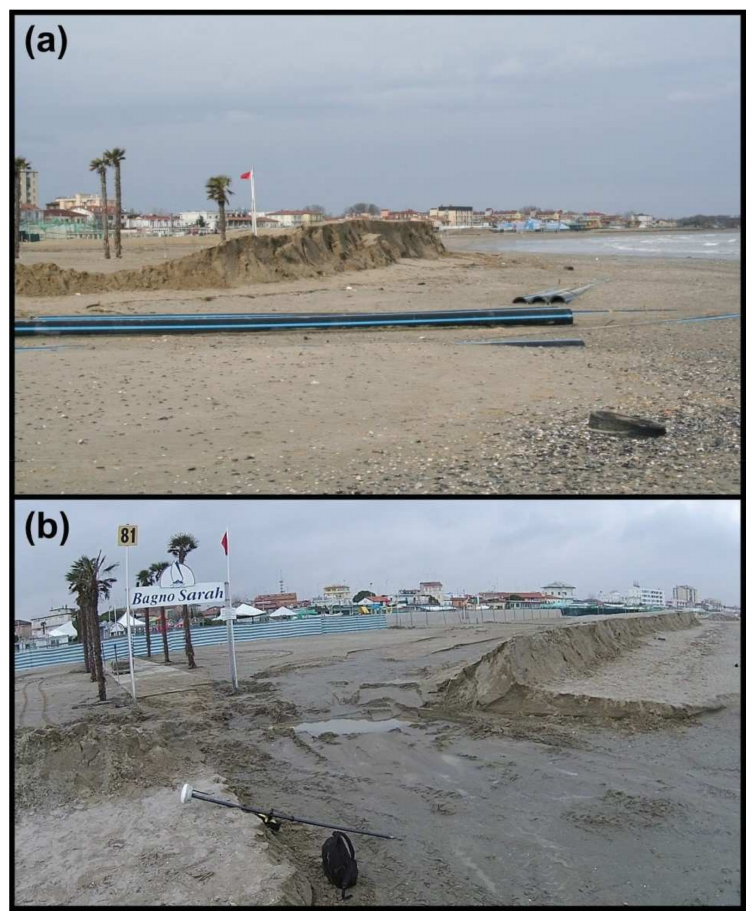
Figure 3. The state of the artificial dune at the study site of Porto Garibaldi (Comacchio, Italy) after the Saint Agatha event of 5–6 February 2015 (Photo: Enrico Duo and Edoardo Grottoli): ( a ) lateral view; and ( b ) front-lateral